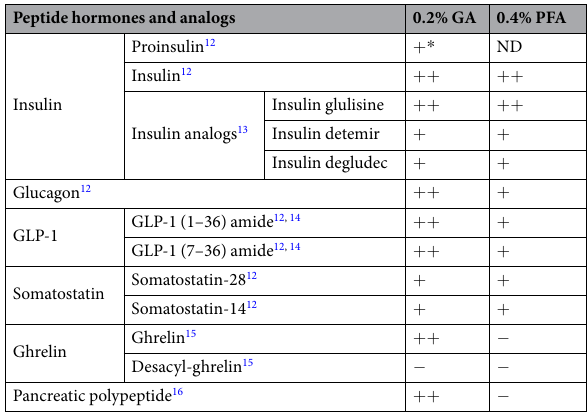
− Table 1. Usability of the improved WB for detection of peptide hormones involved in diabetes. These results were evaluated under a condition using 100 ng of each peptide sample. ++ , more effective; + , effective; − , not or less effective; ND, not determined; * Results from Fig.